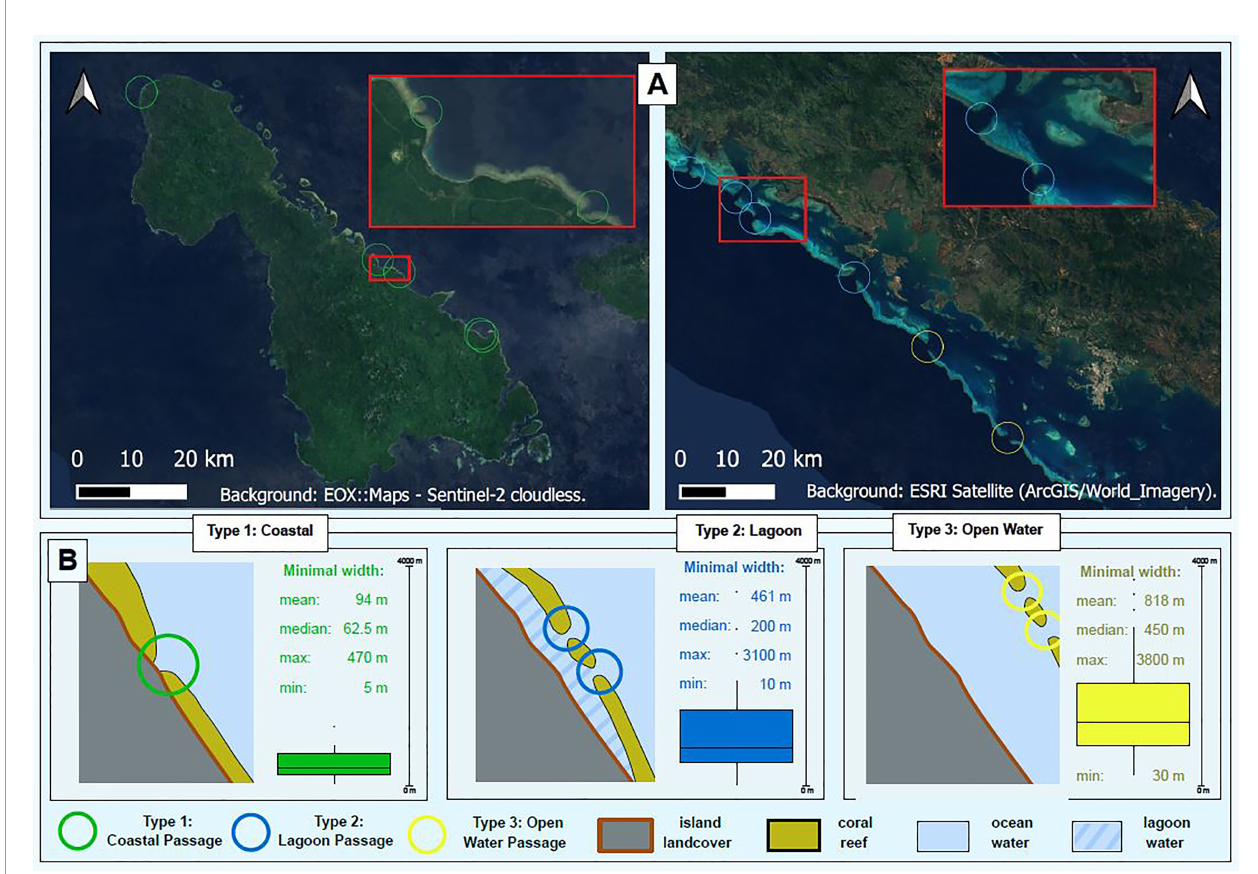
FIGURE 2 | (A) Satellite images of examples of reef passages from the study sites; Type 1 around Malekula on the left, and Types 2 and 3 around Grande Terre on the right; the circles represent the location of the reef passage, and the color of the circles the proposed reef passage type. (B) Conceptual image of the three types of reef passages proposed in this paper with boxplot images of minimal width values for each type; green=Type 1 ‘ Coast ’ , blue=Type 2 Lagoon ’ , yellow= Type 3 ‘ Open Water ’ (NC = New Caledonia, VU =